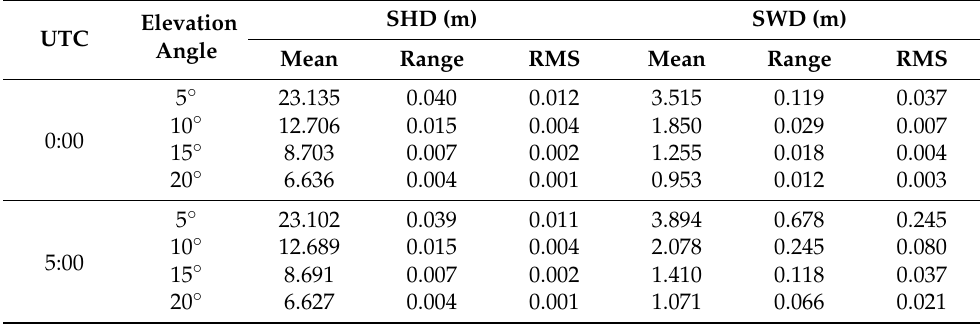
Table 3. Representative ray-tracing slant delays for SHAO located in Shanghai on 21 July 2018.